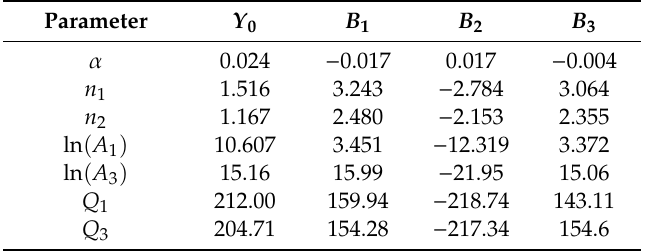
Table 3. The coefficients of the polynomial fitting for α, n2, A3 , and 𝑄